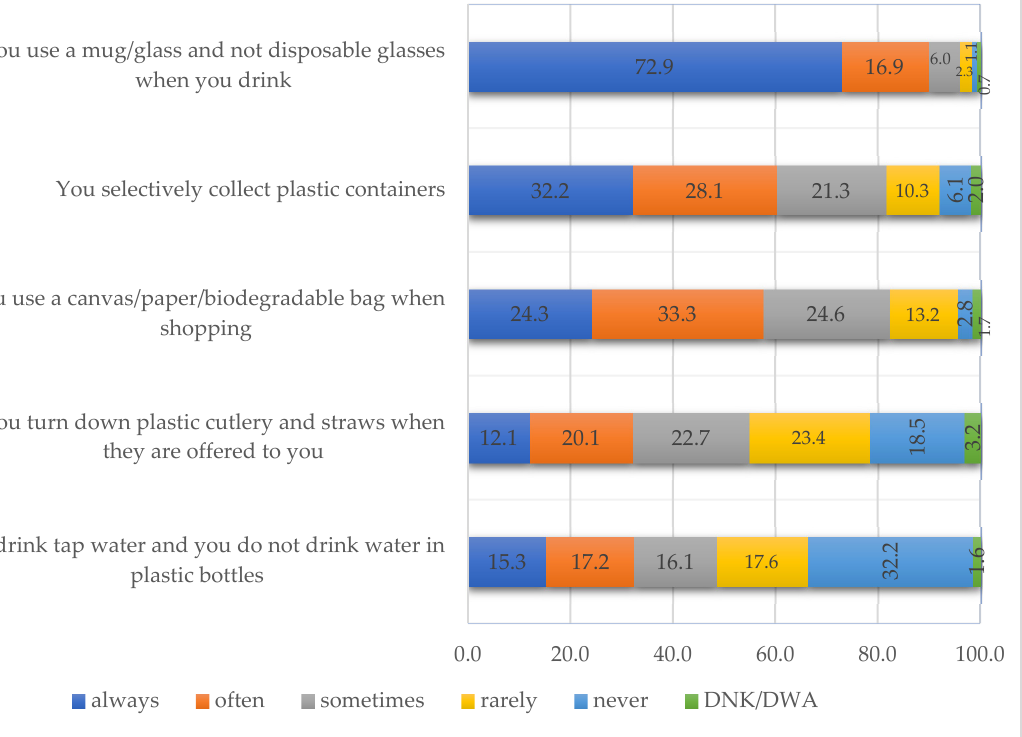
Figure 4. Respondents’ behavior towards plastic consumption in the household.